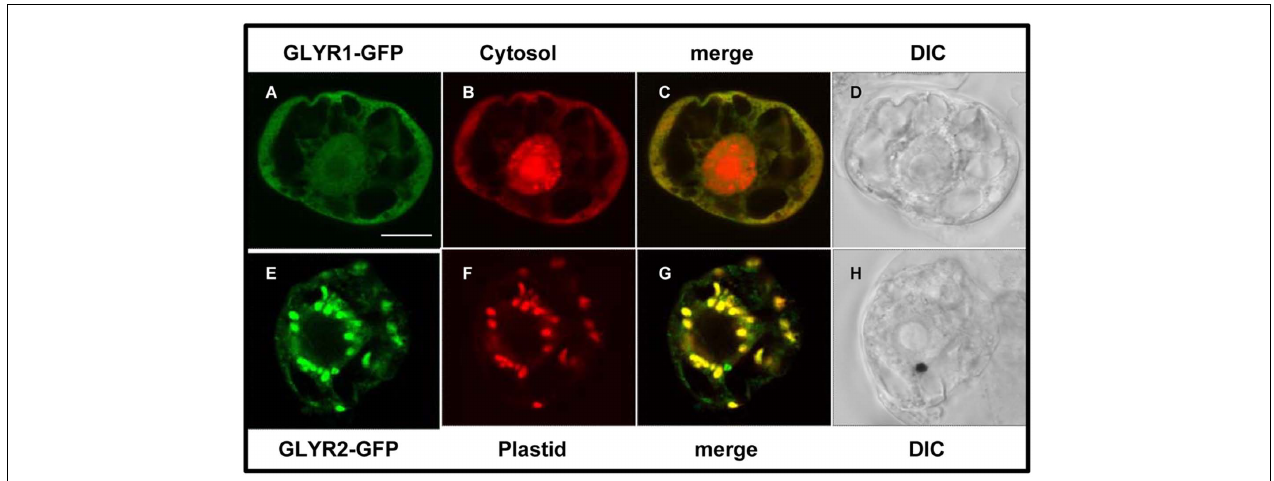
FIGURE 2 | Subcellular localization of Md GLYRs in tobacco BY-2 cells. Representative CLSM images of BY-2 cells (co)expressing (as indicated by the panel labels) MdGLYR1-GFP (A) and the cytosolic marker Cherry (B) or MdGLYR2-GFP (E) and plastid marker PDC pl - E2-mCherry (F) . Processing of cells and viewing using CLSM are described in the Section ‘Materials and Methods’. Shown also is the corresponding merged (C,G) and differential inference contrast (DIC) (D,H) images for each cell. The yellow color in the merged images indicates co-localization. Scale bar in A = 10 µ